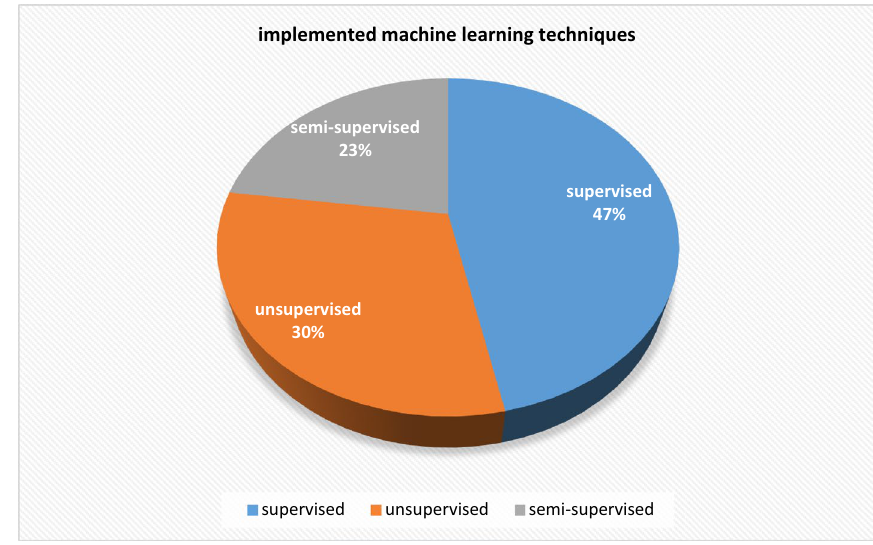
Fig. 6 Implemented machine learning techniques